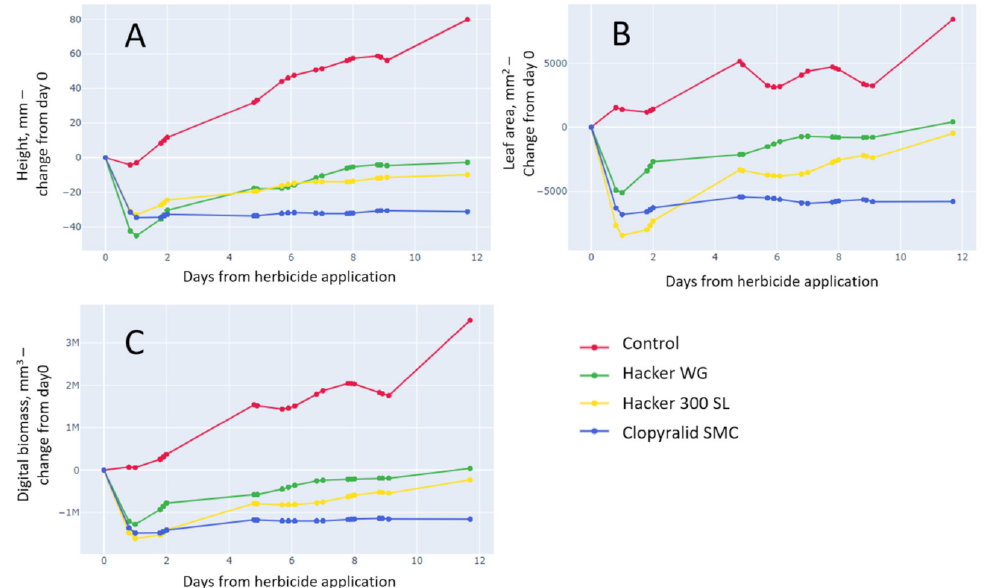
Figure 6. Dynamics of changes in the leaf angle of the cocklebur treated with various herbicides and Control plants. ( A ) Average height of the plants after subtraction of the initial values at the time of the herbicide treatment. ( B ) Average leaf area of the plants after subtraction of the initial values at the time of the herbicide treatment. ( C ) Average digital biomass of the plants after subtraction of the initial values at the time of the herbicide